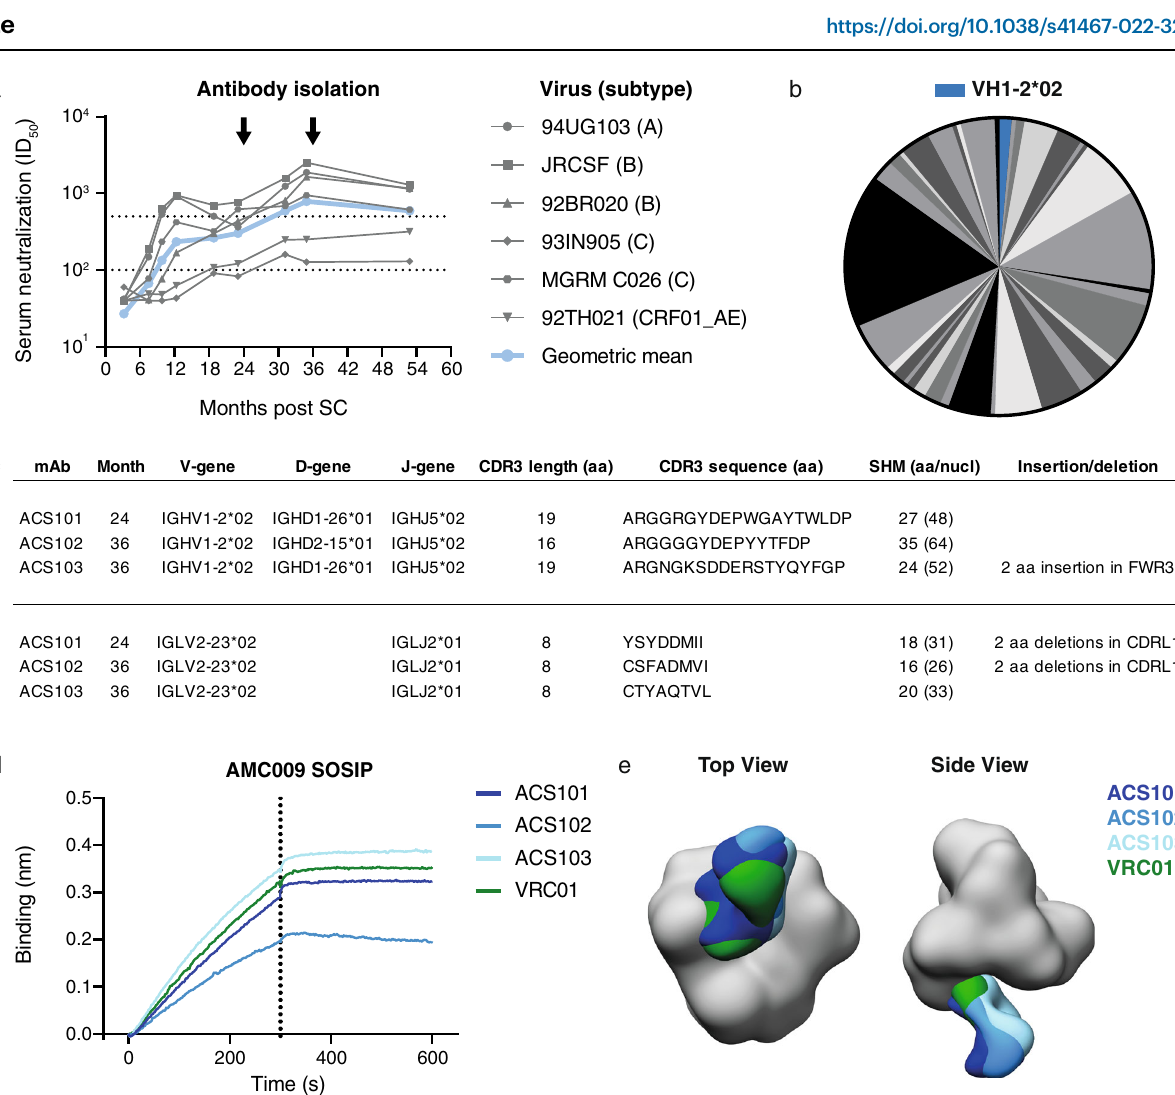
characteristicsofACS101,ACS102andACS103thatusetheVH1-2*02andVL2-23*02 gene segments in their HC and LC, respectively. Somatic hypermutation (SHM) is depicted as the number of amino acid (aa) and nucleotide (nucl) mutations com- paredtotheVH1-2*02andVL2-23*02germlinegenes. d BindingofACS101,ACS102, ACS103, and VRC01 to AMC009 SOSIP using biolayer interferometry. e Negative stain electron microscopy 3D reconstructions of ACS101, ACS102, and ACS103 in complex with AMC009 SOSIP. Fabs were segmented, colored and are shown relative to a reference trimer for visualizationand comparison. VRC01(EMD-8269) Fab was included for comparison